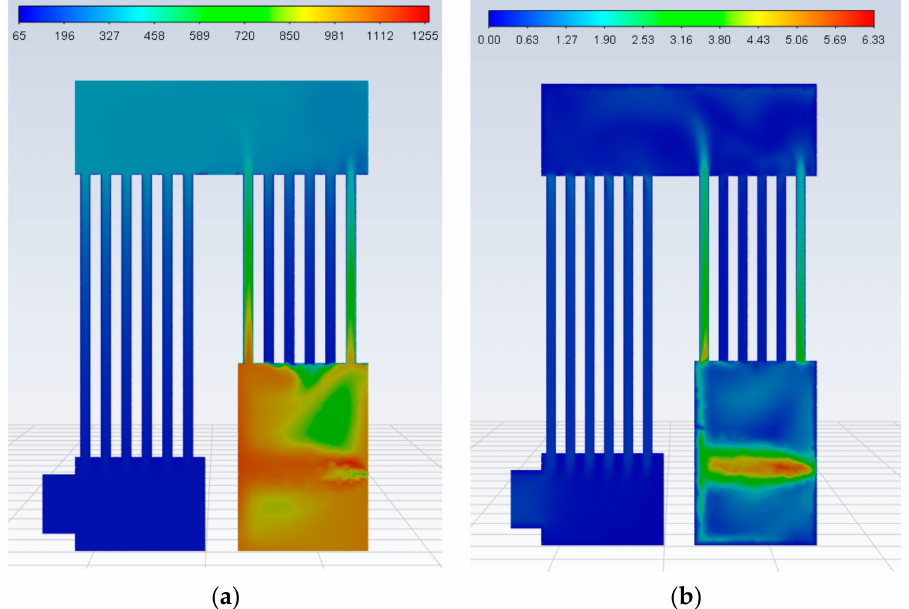
Figure 11. Temperature ( a ) and velocity ( b ) field of designed boiler by using combustion model.